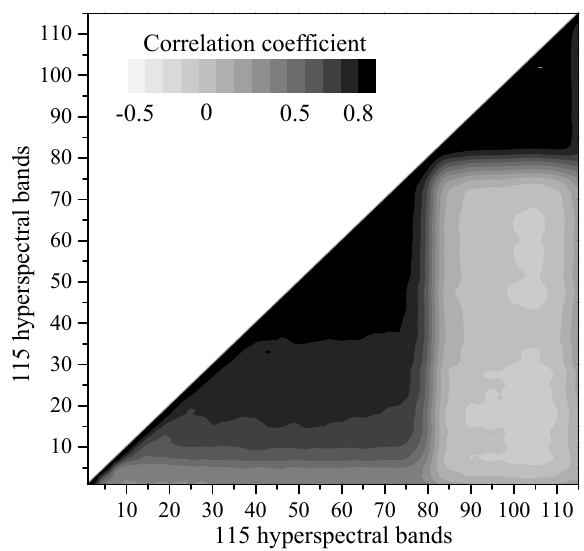
Figure 3. The Pearson correlation analysis among 115 hyperspectral bands. Table 2. Principal Component Analysis (PCA) of hyperspectral variables and their Pearson correlation analysis with soil nutrients. Principal Component Analysis Pearson Correlation Analysis